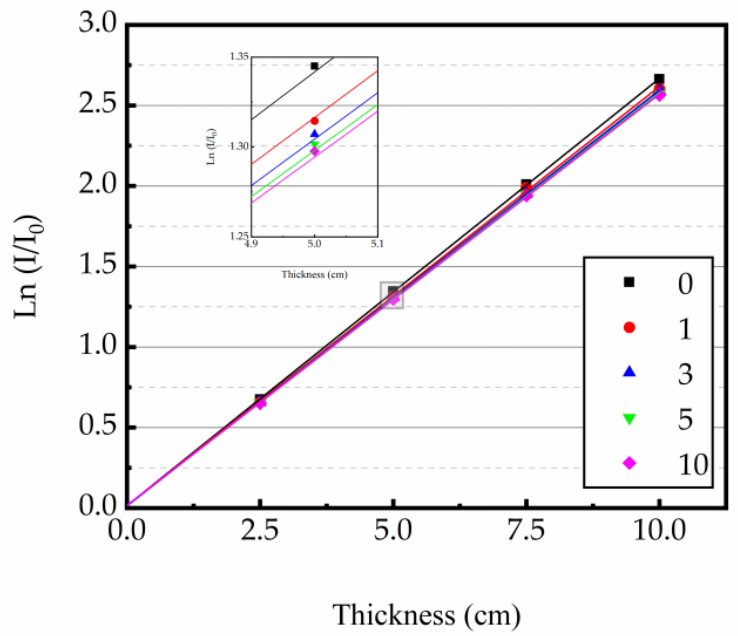
Figure 9. Relationship between ln(I/I 0 ) and concrete thickness at 200 °C.